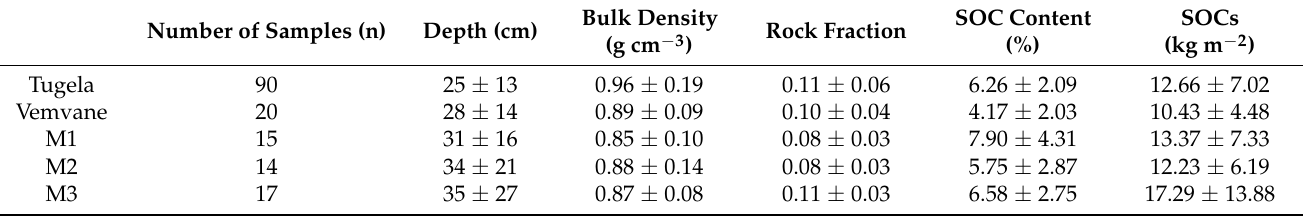
Table 3. Summary of all the catchments’ SOCs, SOC content, soil bulk density, and the rock fraction (mean ± standard